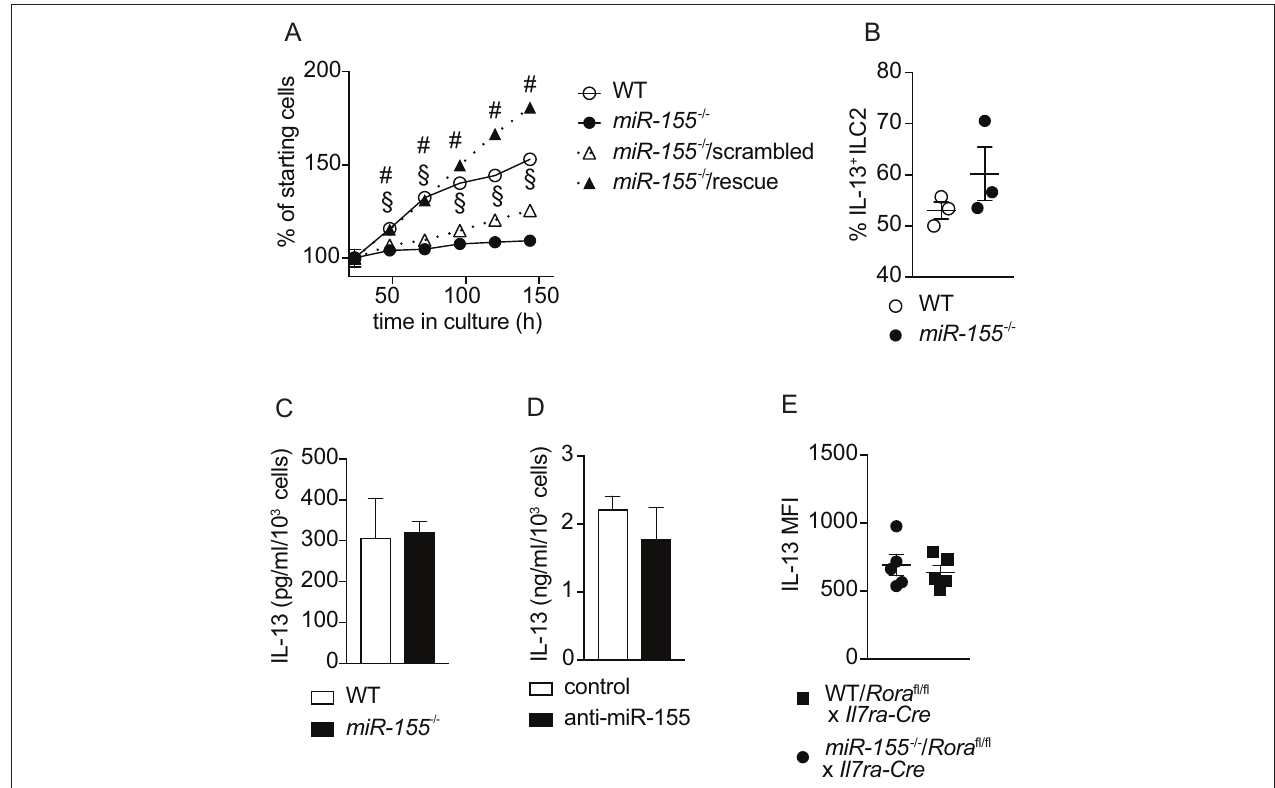
FIGURE 5 | miR-155 is required for ILC2 expansion in vitro but not IL-13 production. ILC2 were isolated from MLN of IL-2/anti-IL-2/IL-25 treated WT or miR155 − / − mice. ILC2 were either left untransduced or transduced with a retrovirus over-expressing the miR-155 sequence to restore miR-155 signaling. Cells were cultured for 6 days in the presence of IL-7 and IL-33 (both at 10ng/ml). (A) Daily ILC2 counts. (B) Intracellular IL-13 staining of WT or miR155 − / − ILC2 from 5-day cultures in (A) analyzed by flow cytometry. (C) Secreted IL-13 was quantified in supernatants from the cultures of WT and miR155 − / − ILC2 using ELISA (data corrected for cell counts). (D) Secreted IL-13 was quantified in supernatants from WT ILC2 treated with negative control siRNA or miR-155 knockdown siRNA harvested after 2 days using ELISA (data corrected for cell counts). (E) Intracellular IL-13 expression in ILC2 isolated from the MLN of IL-33-treated lethally-irradiated B6SJL mice that had received mixed BM from Rora flox / flox x Il7ra Cre mice with WT or miR155 − / − BM. Cells were treated with PMA/ionomycin in the presence of protein transport inhibitor. Data are representative of at least two independent experiments. Two-way ANOVA with Sidak’s multiple comparisons test (A) , # p ≤ 0.05 compared to miR155 − / − , § p ≤ 0.05 compared to control transduced miR-155 − / −